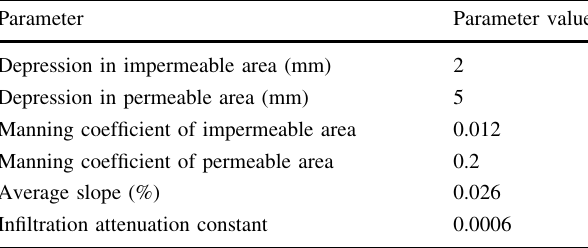
Table 3 Parameter value of urban rainstorm and flood model